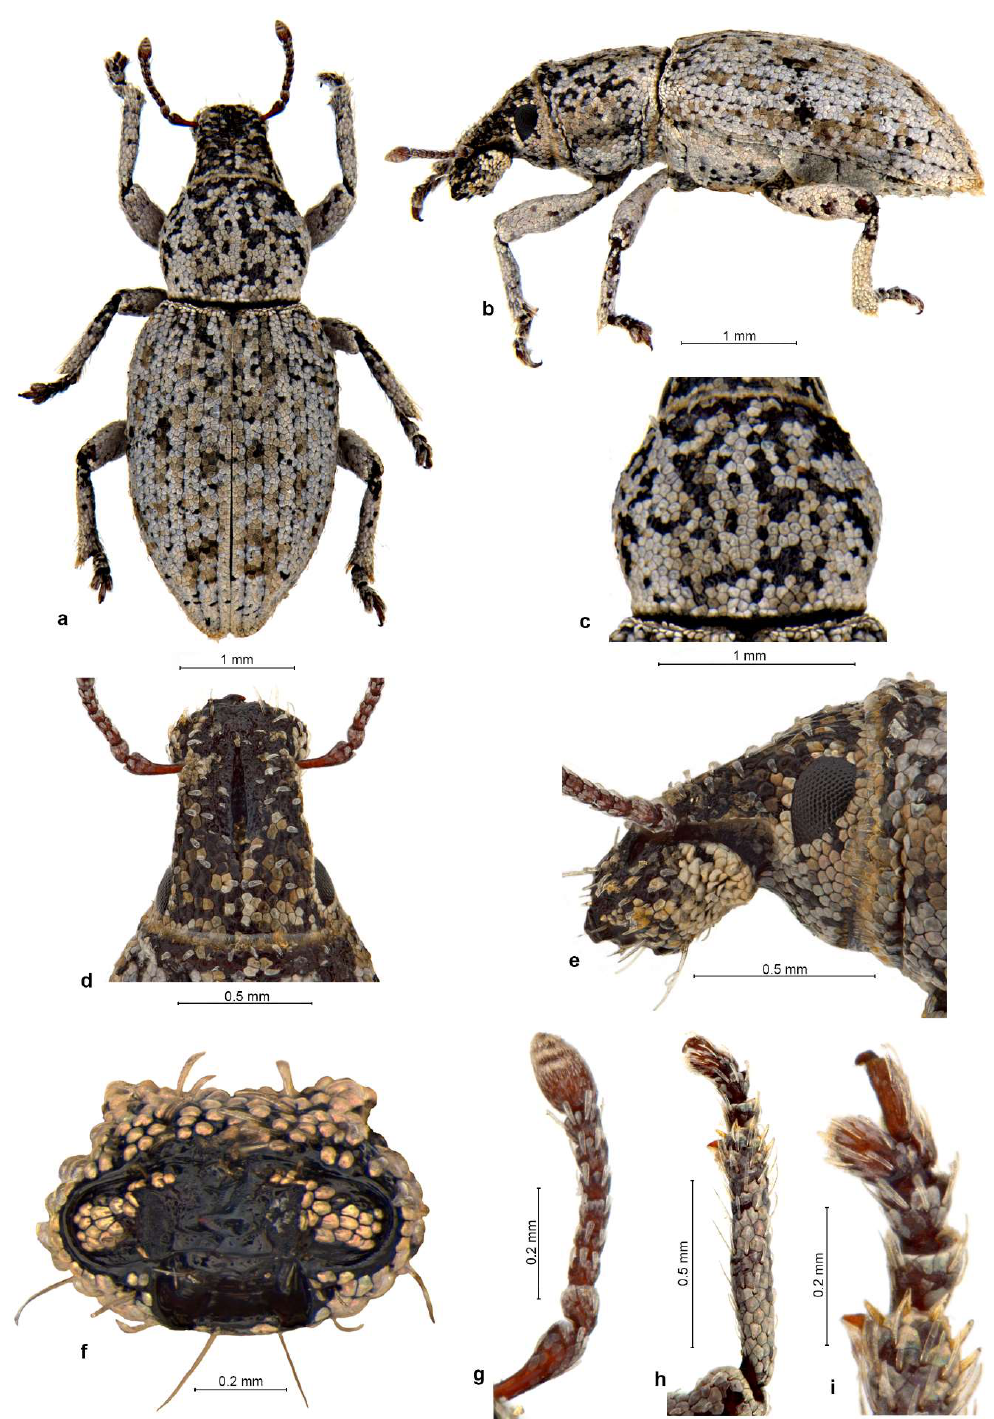
Figure 8. Philetaerobius garibebi sp. n. (Karibib), ♂ —dorsal habitus ( a ); left lateral habitus ( b ); pronotum, dorsal view ( c ); head, dorsal view ( d ); head, lateral view ( e ); rostrum and mandibles, frontal view (f); right antenna, dorsal view ( g ); right protibia and -tarsus, dorsal view ( h ); right protarsus, lateral view ( i ).